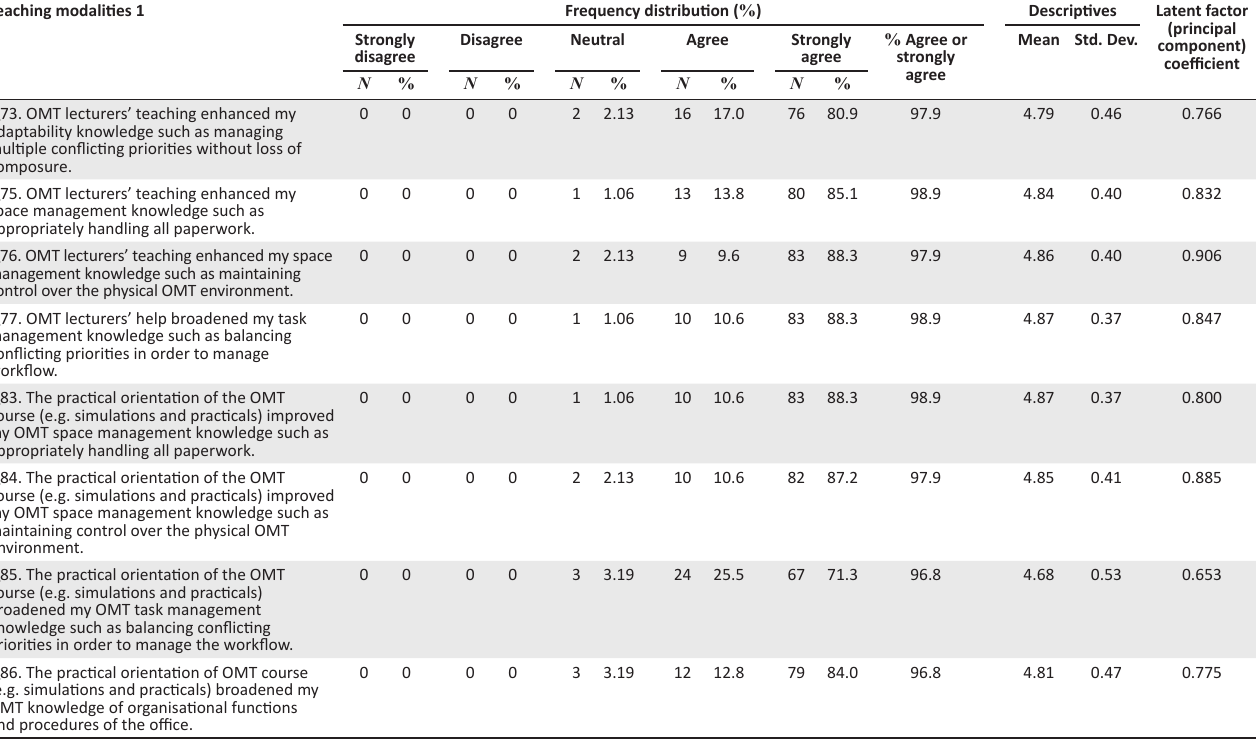
TABLE 11: Influence of teaching modalities (1).